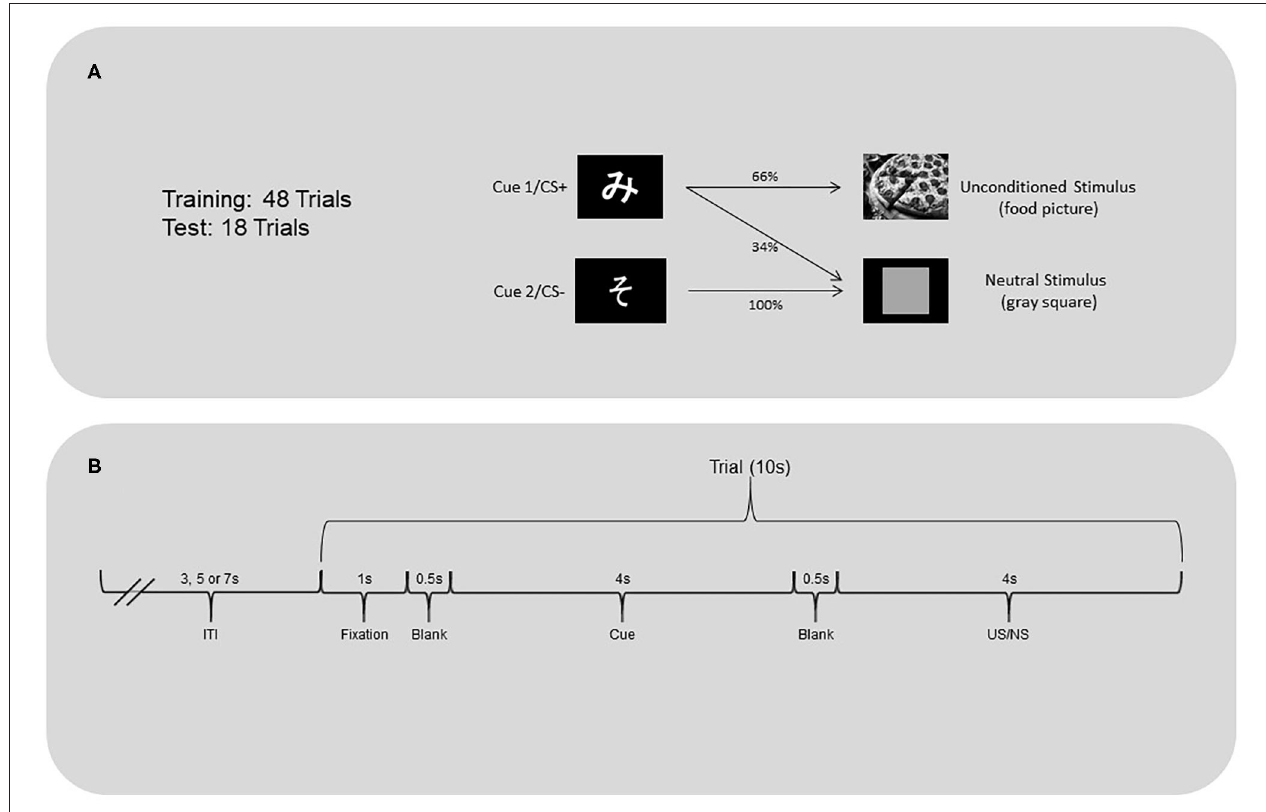
FIGURE 1 | (A) Classical conditioning task and (B) trial timeline.